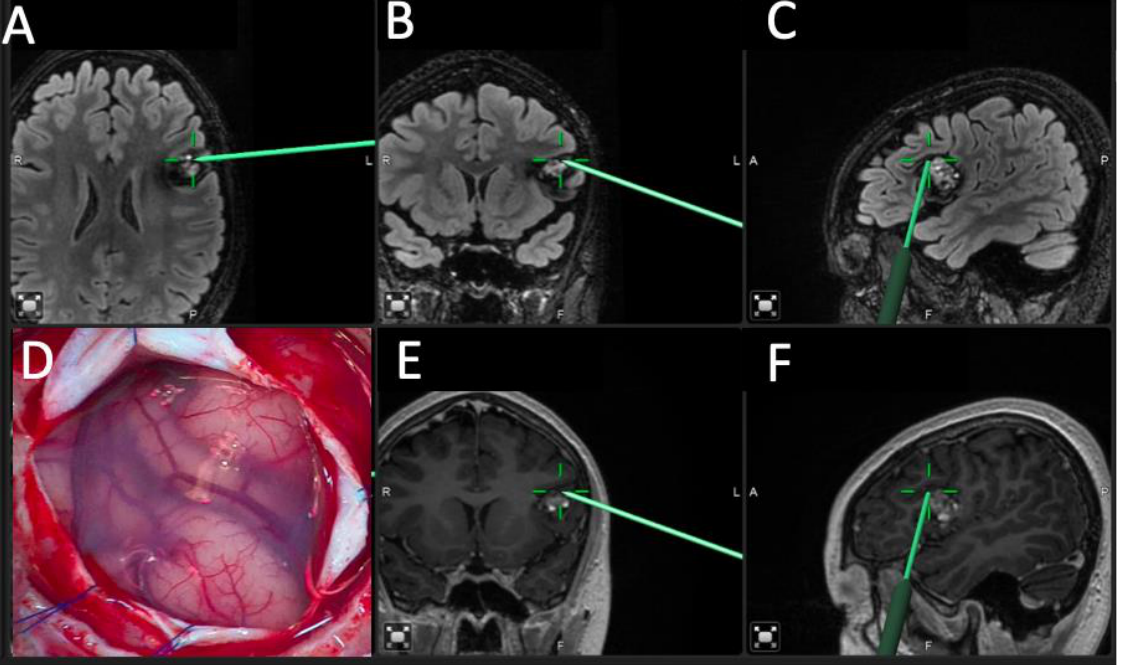
Figure 2 - Intraoperative use of Brain Lab neuronavigation system to perform a small craniotomy (A, B, C, E and F). Cortical aspect of guided craniotomy